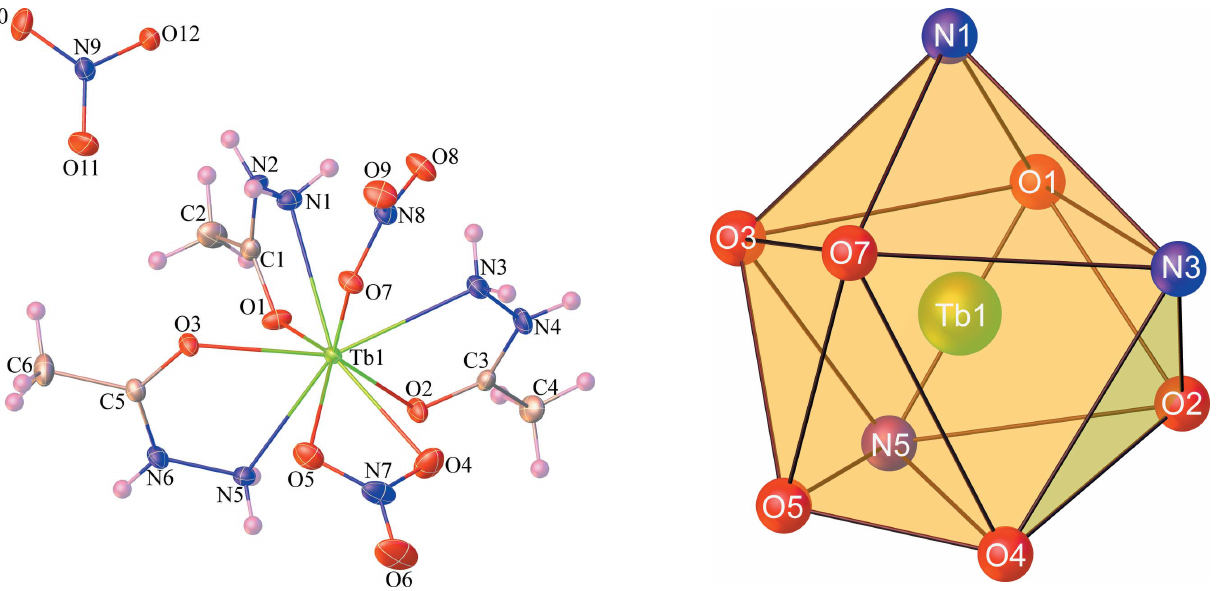
Figure 1 Molecular structure of 1 , showing the atom-labeling scheme. Displace- ment ellipsoids are drawn at the 50% probability level.